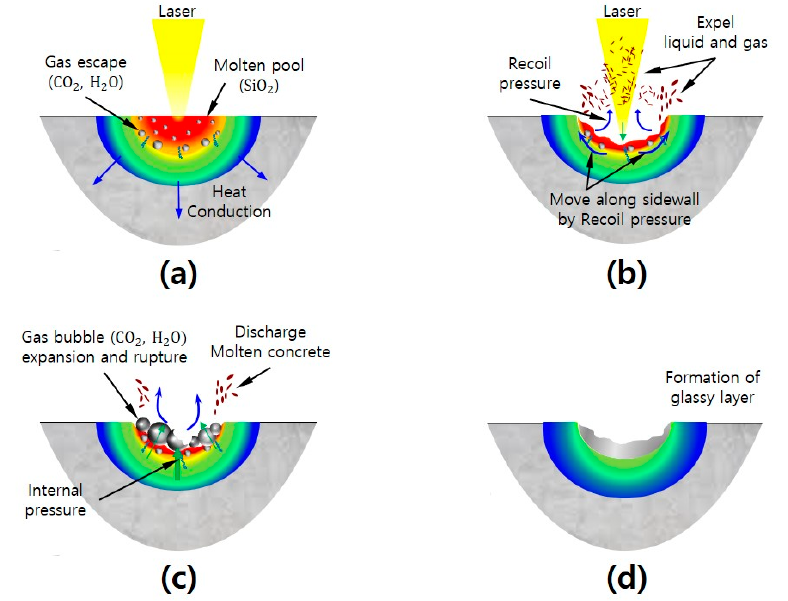
Figure 13. Schematic diagram of interaction mechanism between laser and cement-based materials. ( a ) generation of molten pool by laser; ( b ) discharging the vapor mixed with the liquid; ( c ) creation of gas bubbles from decomposition of cement-based material; ( d ) formation of glass layer from solidification of molten pool.